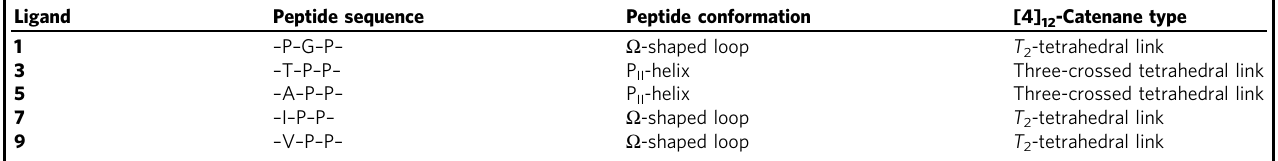
Table 1 Types of [4] 12 -catenanes formed in terms of the fi rst amino acid residue in the tripeptide ligand sequence Ligand Peptide sequence Peptide